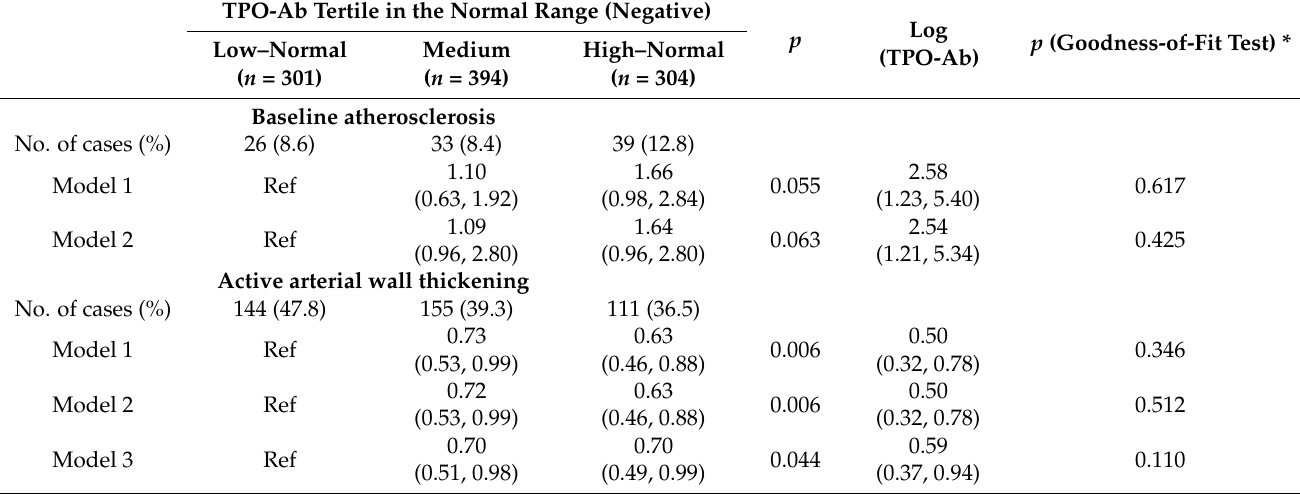
Table 4. Odds ratios (ORs) and 95% confidence intervals (CIs) of anti-thyroid peroxidase antibody (TPO-Ab) titer for baseline atherosclerosis and active arterial wall thickening among participants with thyroid-stimulating hormone (TSH) values in the normal